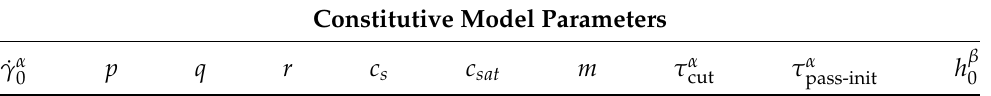
Table 1. Material parameters to be determined from a deep-learning method and experimental